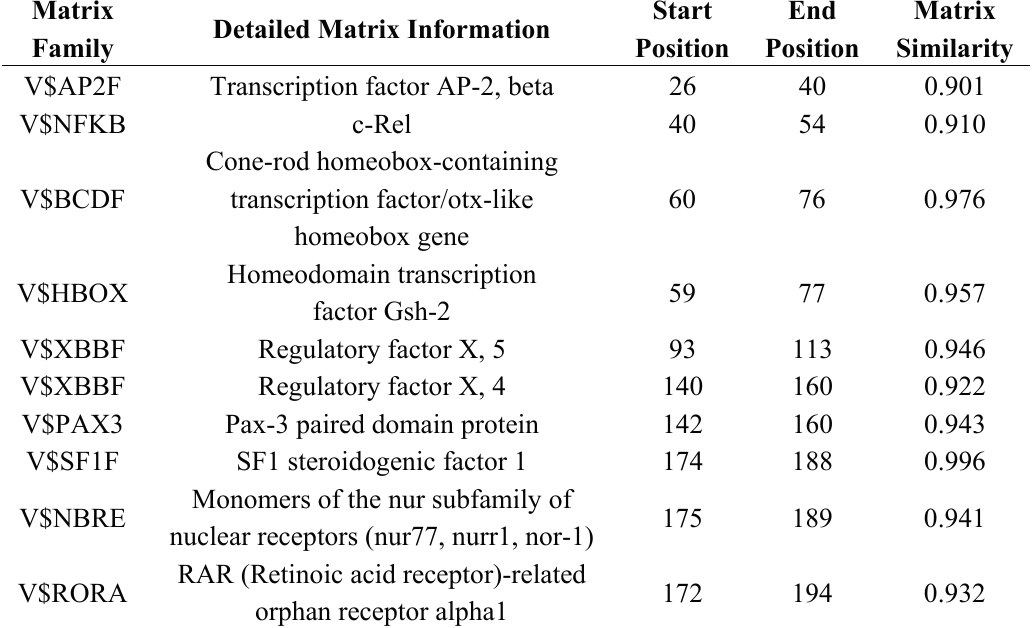
Table 1. Transcription factor binding sites Information. Matrix Families: Similar and/or functionally related TFBS are grouped into so-called matrix families. Matrix similarity: the matrix similarity is calculated as described in the MatInspector papers, a perfect match to the matrix gets a score of 1.00